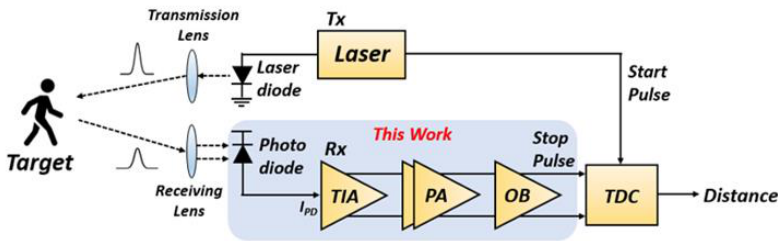
Figure 1. Block diagram of a typical light detection and ranging (LiDAR) sensor.